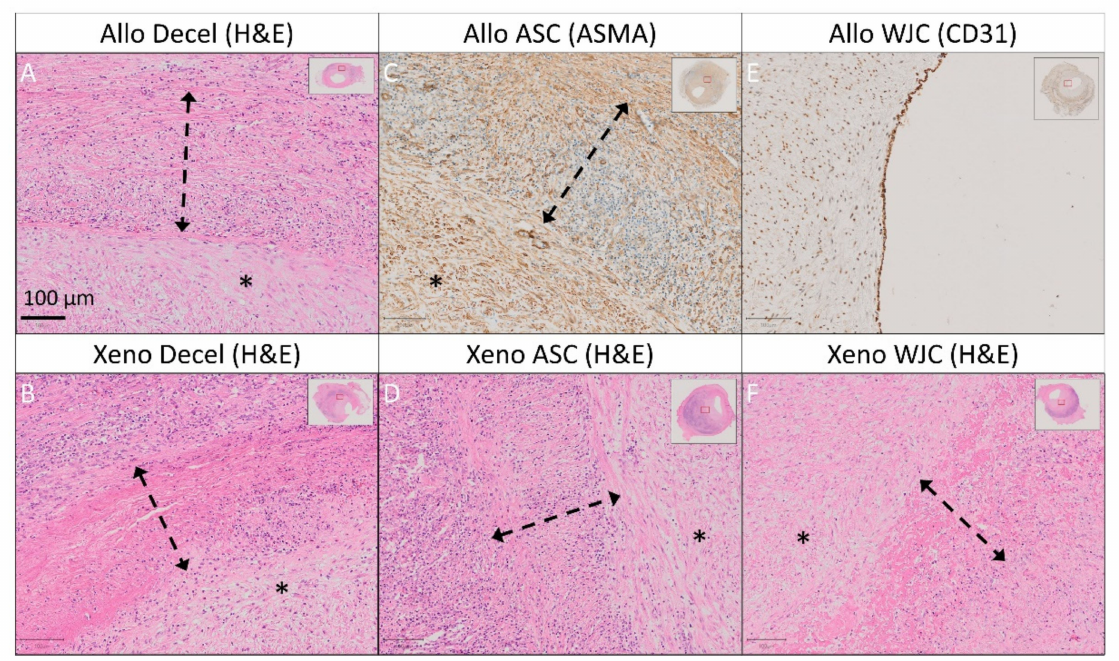
Figure 10. Detailed histology and immunohistochemistry of experimental pericardial vascu- lar patches in porcine carotid arteries 1 month post-implantation. We implanted decellularized ( A ) porcine allograft and ( B ) ovine xenograft patches, ( C ) allograft and ( D ) xenograft patches re- cellularized with autologous adipose tissue-derived stromal cells (ASCs), and ( E ) allograft and ( F ) xenograft patches recellularized with allogeneic Wharton’s jelly mesenchymal stem cells (WJCs). Representative cross-sections of the midgraft regions are shown. We performed staining with hema- toxylin and eosin (H&E) and immunohistochemistry of alpha-smooth muscle actin (ASMA) and endothelial CD31. A double arrow denotes the implanted patch material, and an asterisk denotes the luminal side of the patch and neo-intimal tissue (magnification 20 ×